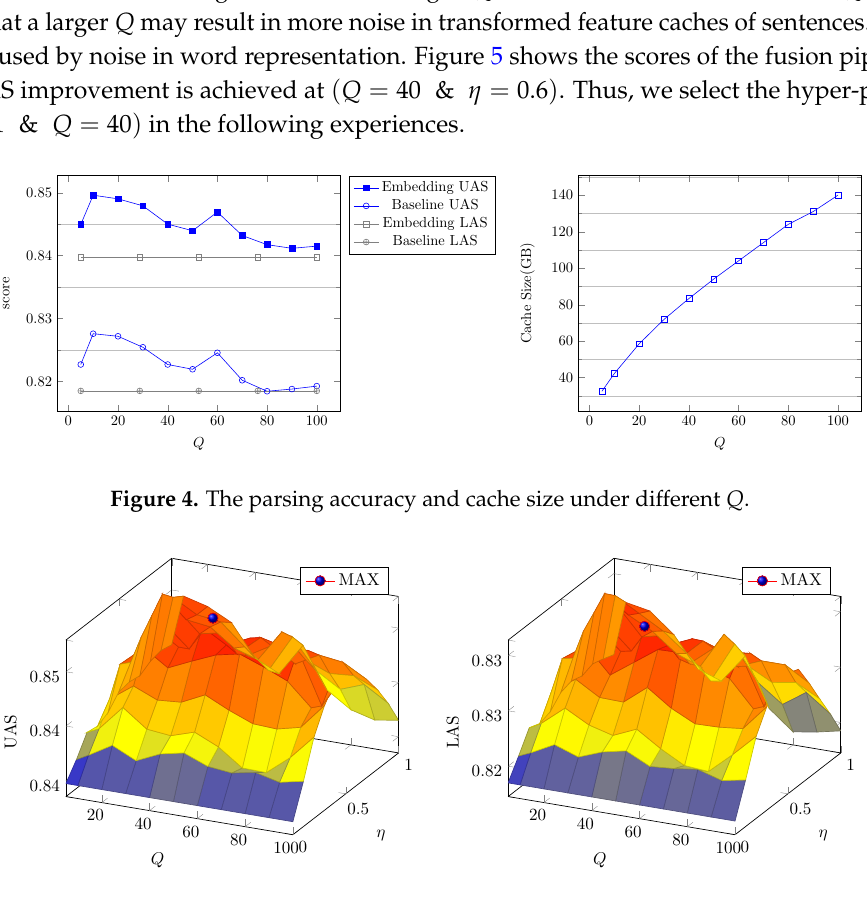
Figure 5. The fusion parsing accuracy under different Q and η .